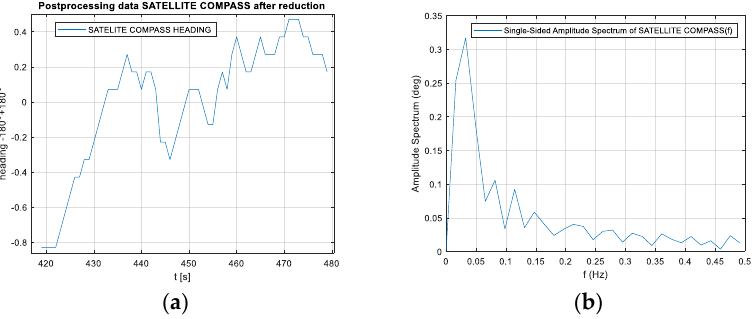
Figure 20. ( a ) Heading distortions. ( b ) Frequency spectrum of the heading records. Heading distortions